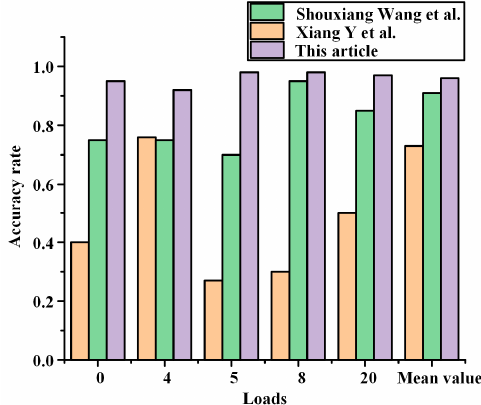
Figure 13. Load comparison diagram of low identi fi cation accuracy.